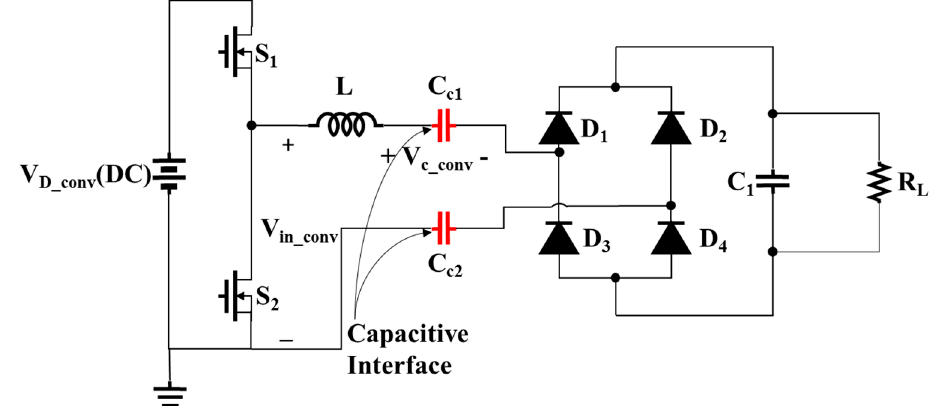
Figure 1. The conventional capacitive power transfer (CPT) system.